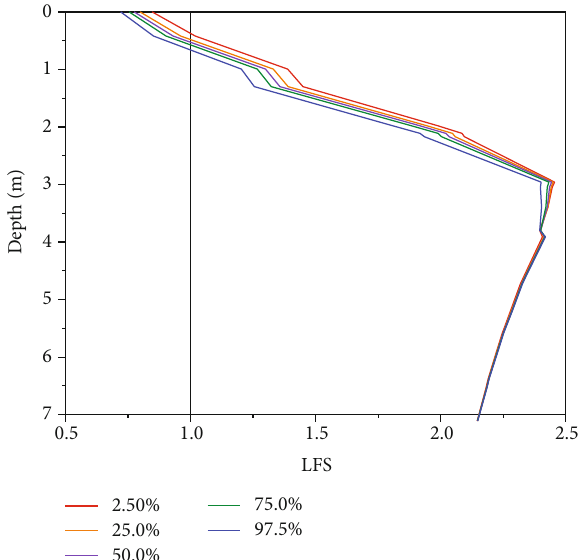
Figure 12: Local factor of safety at the observation pro fi le with di ff erent percentiles of the SWRC ( t = 96h ).